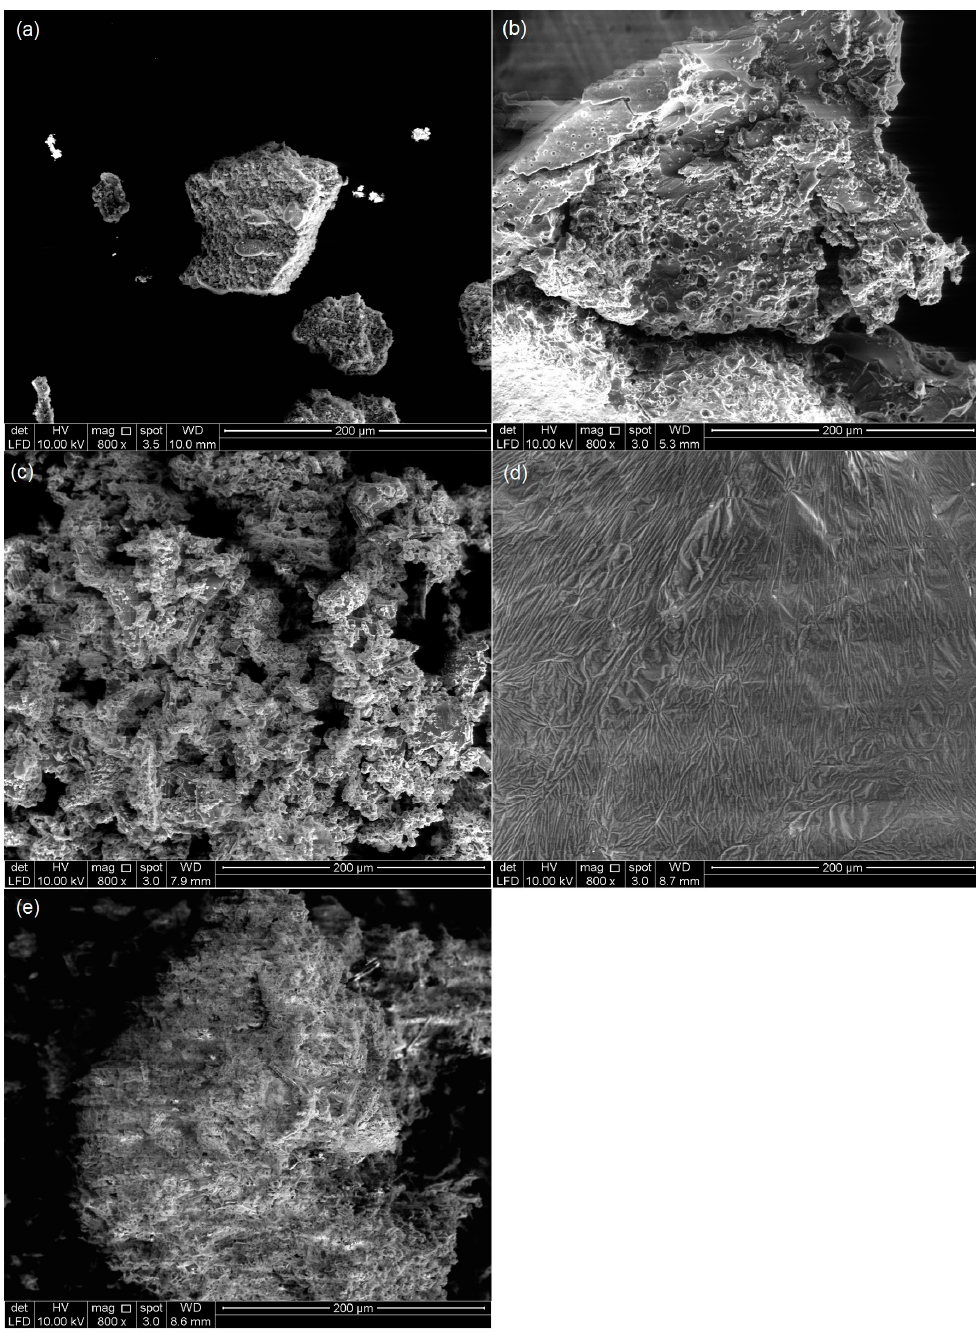
Figure 3. Scanning Electron microscopy (SEM) images at 800x magnification of polymer ( a ) P10, ( b ) P15, ( c ) P21, ( d ) P25, and ( e ) P51.